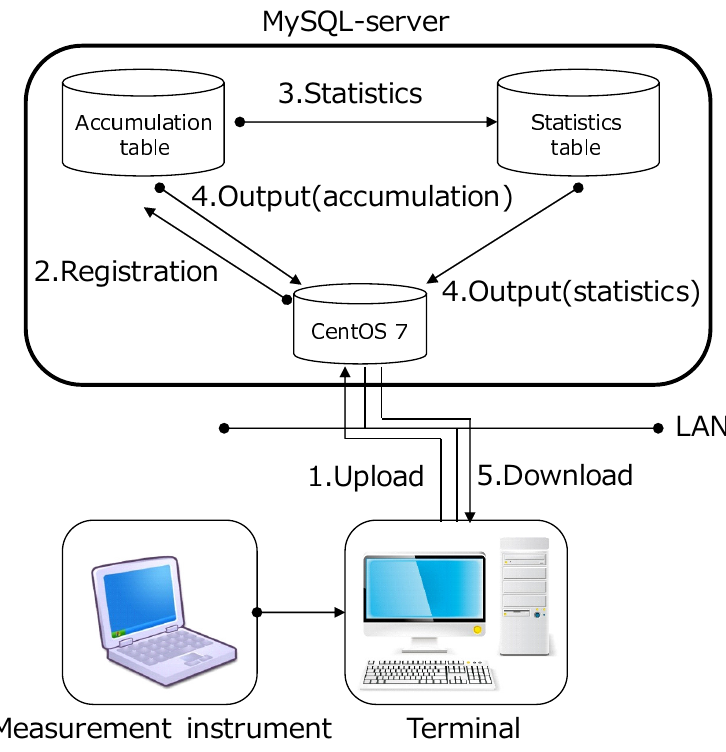
Figure 5. Structure of the implemented